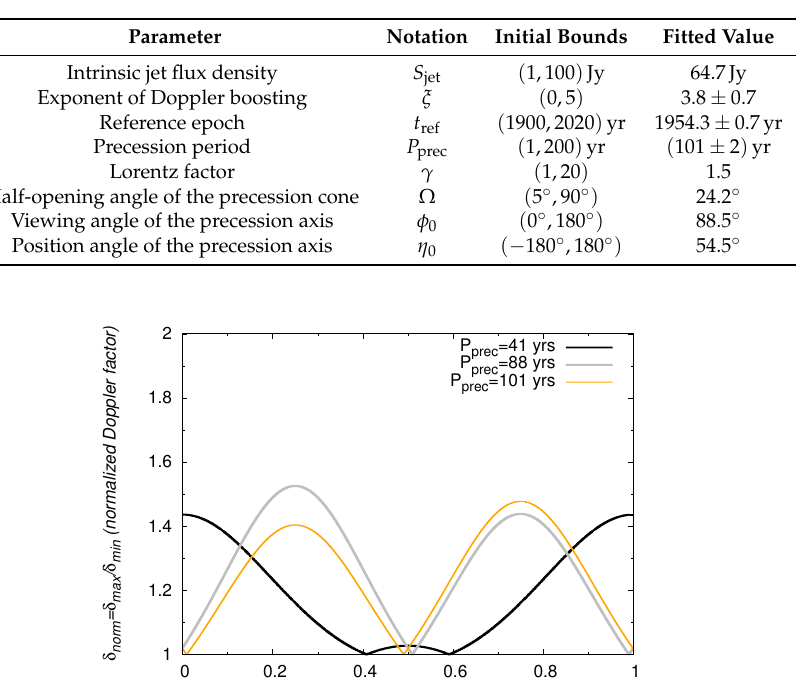
Table 2. Table of fitted parameters in the precession model with the broadened initial parameter bounds. The first column contains the parameter name, the second column lists the notation, the third one contains the initial bounds for the Levenberg–Marquardt algorithm, and the fourth column contains the fitted values.